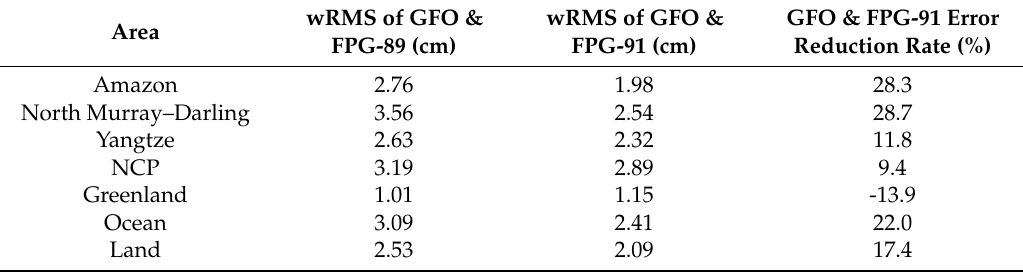
Figure 9. Typical regions selected for GFO & FPG-89 and GFO & FPG-91 models’ comparisons. Table 5. Yearly-average latitude-weighted root mean squares (wRMS) of regional spatial differences plots (SDP) in GFO-KBR & FPG-89 and GFO-KBR & FPG-91 models. The final column shows the error reduction rate (ERR) of GFO-KBR & FPG-91 with respect to GFO-KBR & FPG-89 in terms of regional wRMS.